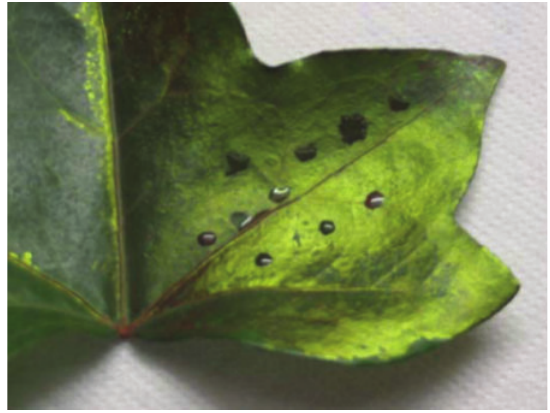
Figure 22 CCD imaging of applied pesticide solutions droplets on an ivy leaf partly coated with rhodamine 6G nano-crystallite layer (excitation wavelength: 360 nm).